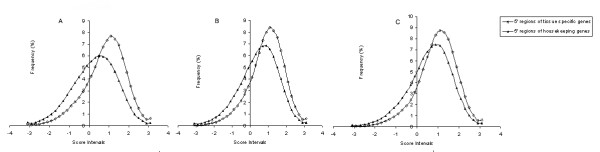
Nucleosome formation potential score distributions for 5' regions at different positions from the gene start site in housekeeping and tissue specific genes. The 5' regions of 800, 1200 and 1600 bp from the gene start site of housekeeping and tissue specific genes were taken for the analysis. Frequency distribution histograms were plotted for Recon scores in various intervals (range -3.2 to +3.2). (A), (B) and (C) show the distribution of nucleosome formation potential scores at 800, 1200 and 1600 bp upstream from the gene start site respectively. As we move upstream from the gene start site, the difference in the nucleosome formation potentials between housekeeping and tissue specific genes gradually fades away.